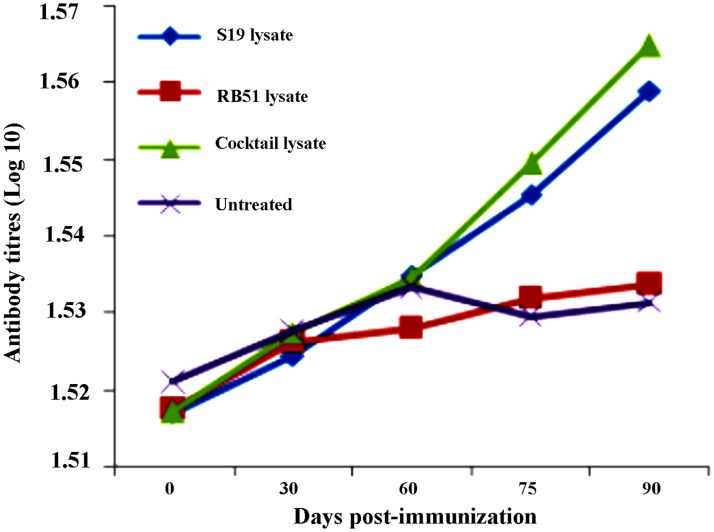
Titers of anti-Brucella antibodies in lysate treated and untreated cattle.